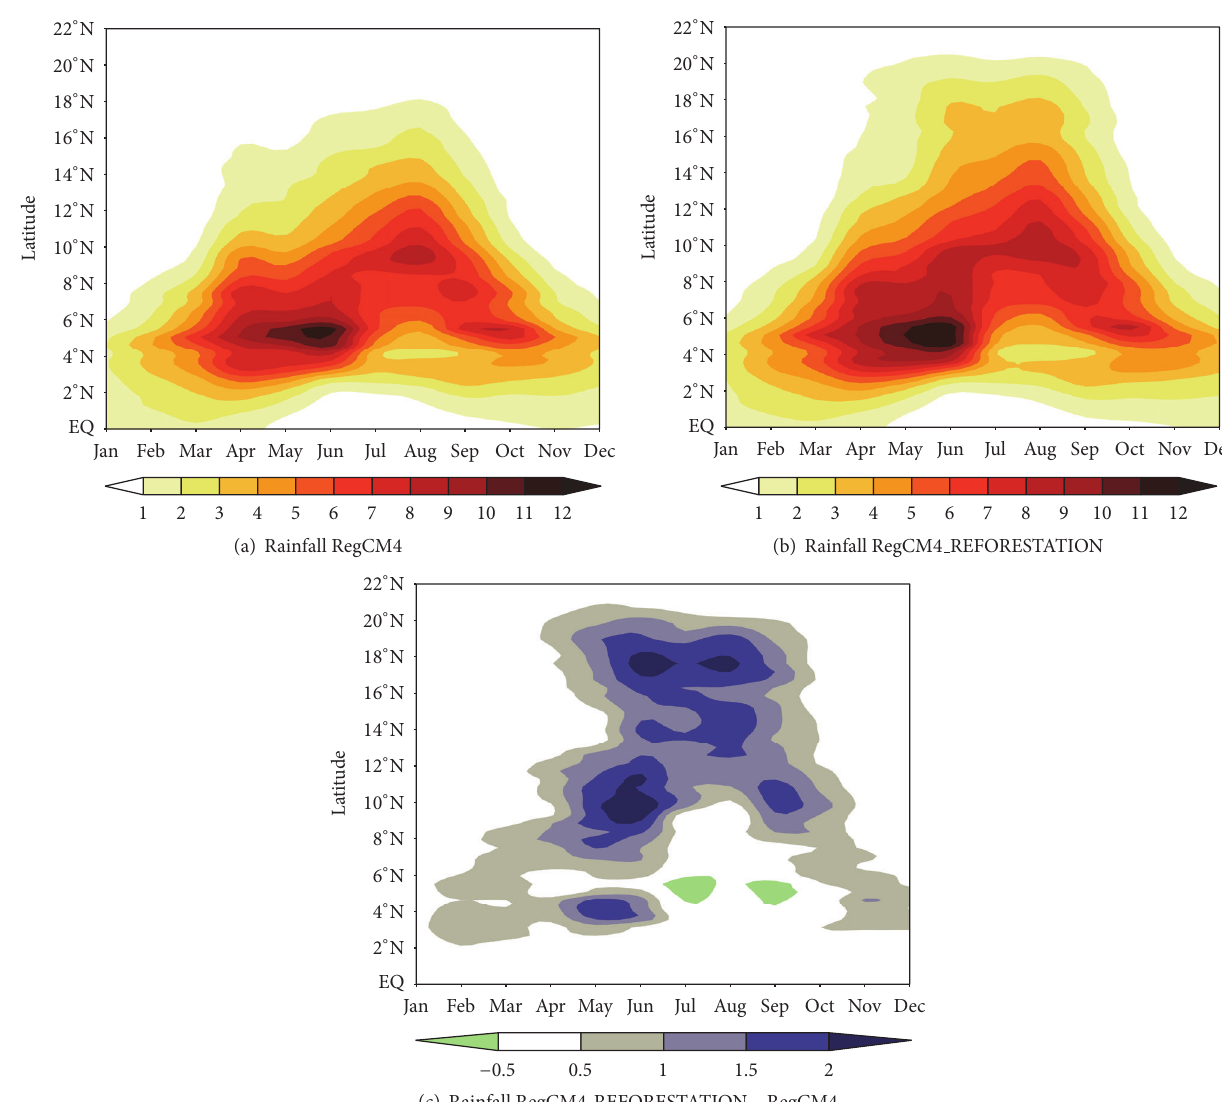
Figure 6: Hovmo¨eller diagram of rainfall averaged between 10 ∘ W and 10 ∘ E and from 2003 to 2009 for both runs and their difference.